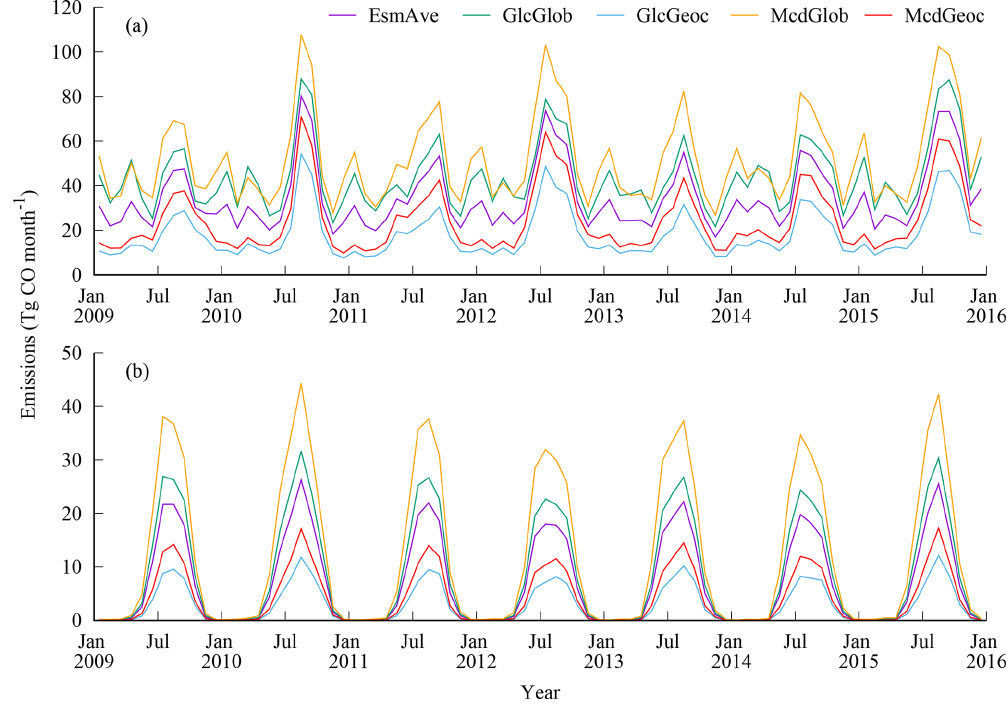
Figure 3. Monthly CO emissions (TgCOmonth − 1 ) for EsmAve (purple line), GlcGlob (green line), GlcGeoc (blue line), McdGlob (orange line), and McdGeoc (red line) over (a) the globe and (b) the southern Africa region within the black rectangle shown in Fig. 2f. Table 3. Mean AGB (gm − 2 ) from the four BB emissions estimates for forest and shrub/savanna/grass over southern tropical Africa (Fig. 2b). Numbers in parentheses are the annual AGB decrement (%) caused by